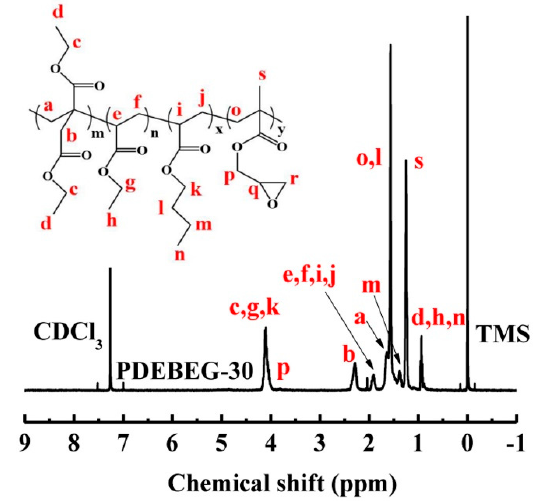
Figure 4. 1 H NMR spectra of PDEBEG-30.